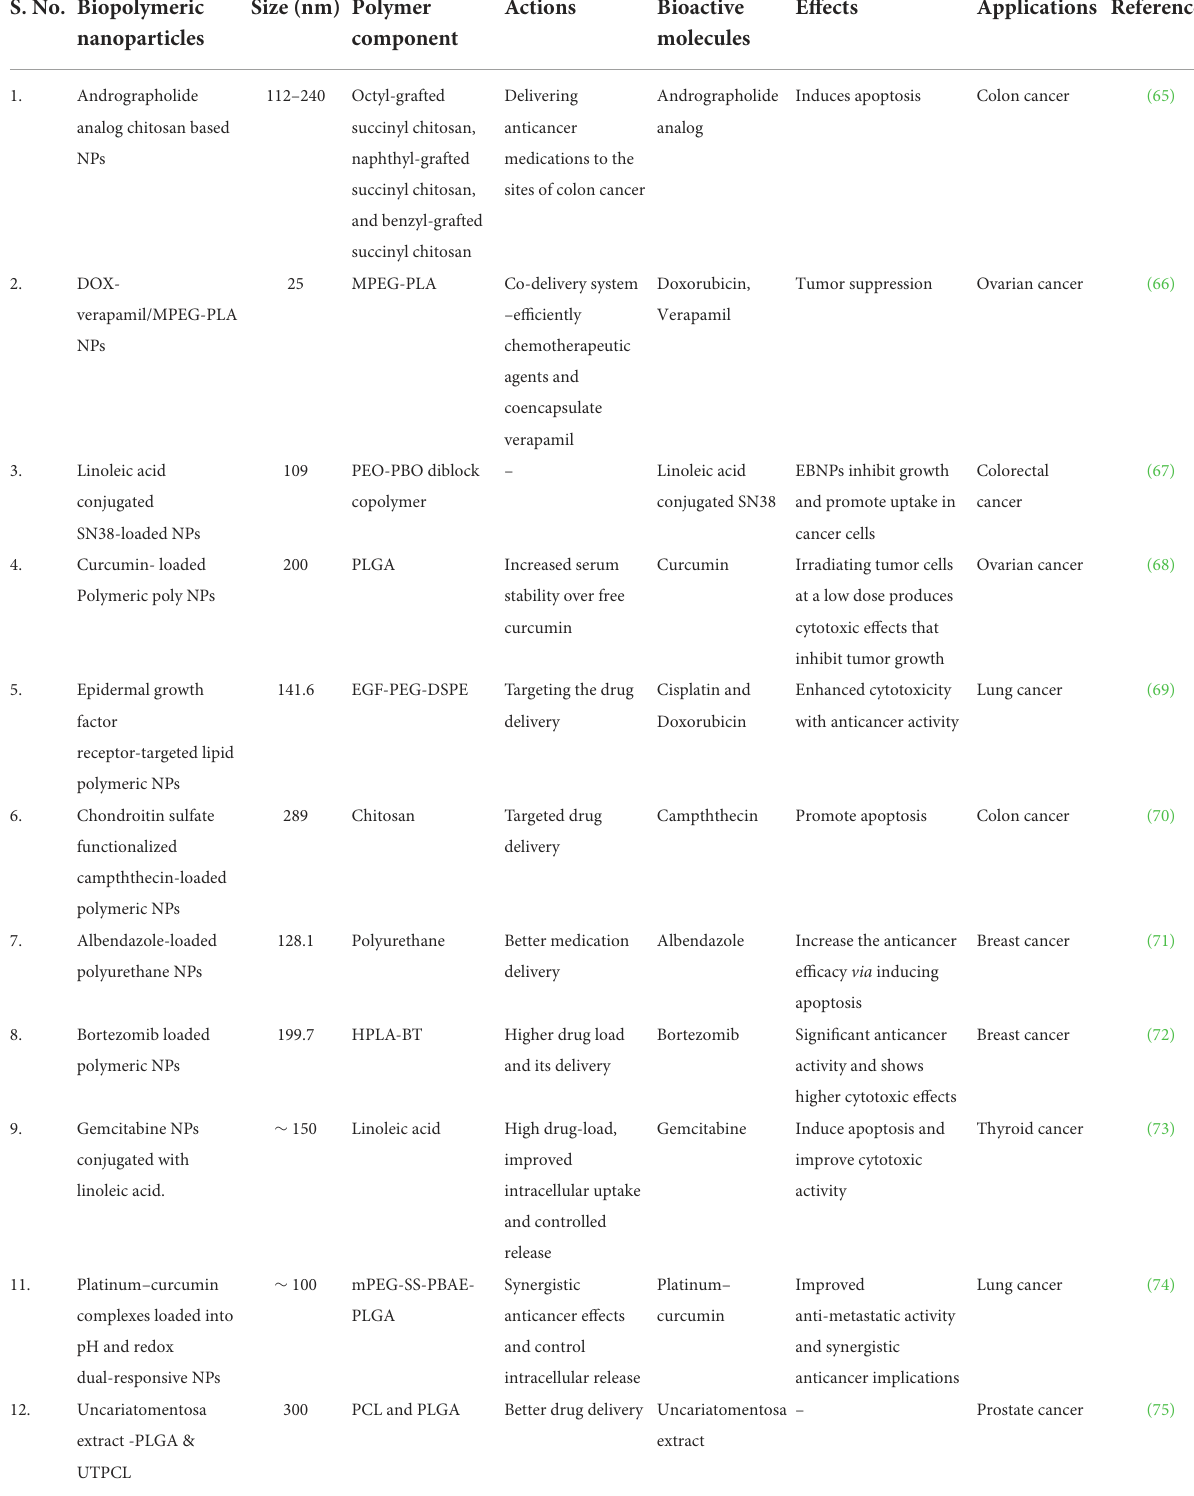
TABLE 2 Nanoparticles based numerous biopolymeric compounds and their action in various cancer treatments. S. No.